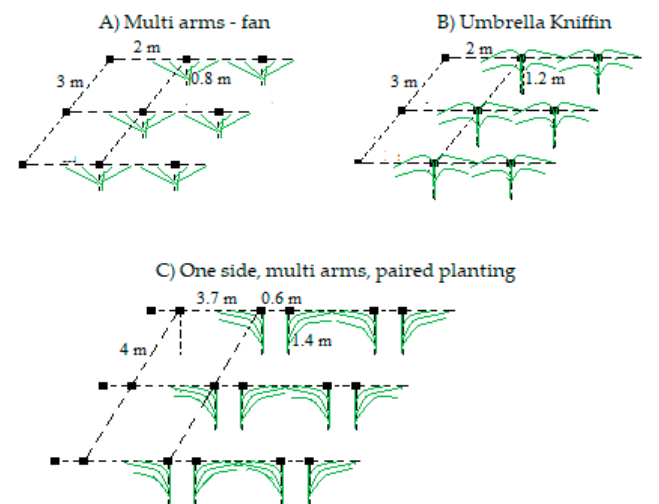
Figure 1. Training systems ( A, B, C ) for investigated vineyard. Table 2. Physical and chemical properties of investigated soil.